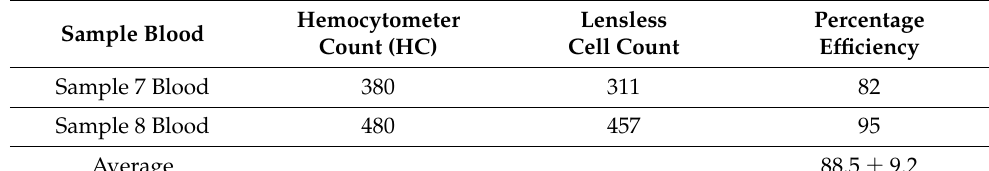
Hemocytometer Count (HC)